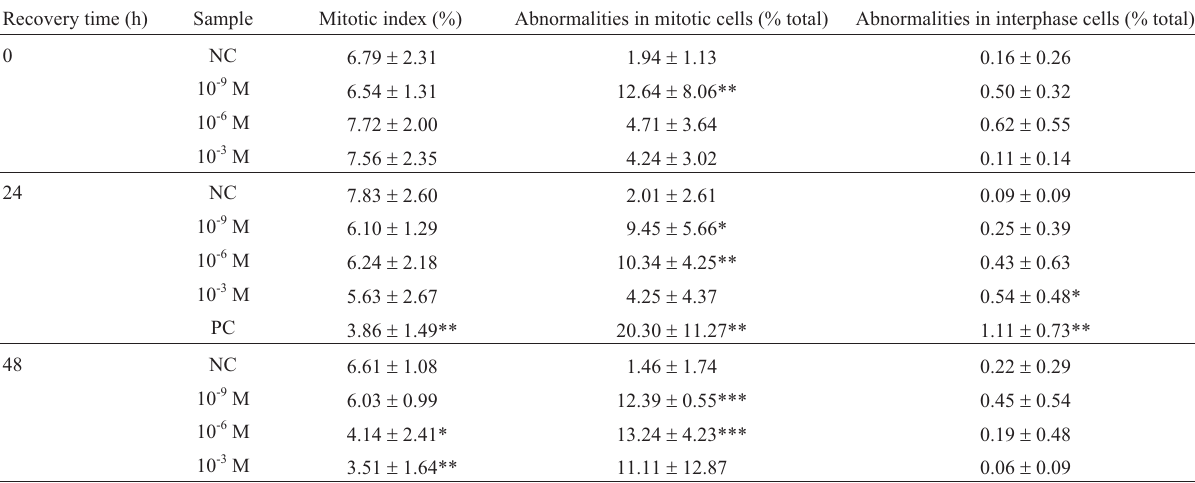
Table 1 - Mitotic index and abnormalities in mitotic and interphase cells in root tip meristems of Allium cepa L. incubated with Br-oxph (10 -9 , 10 -6 or 10 -3 M) for 3 h followed by no recovery interval (0 h) or by recovery for 24 h and 48 h.